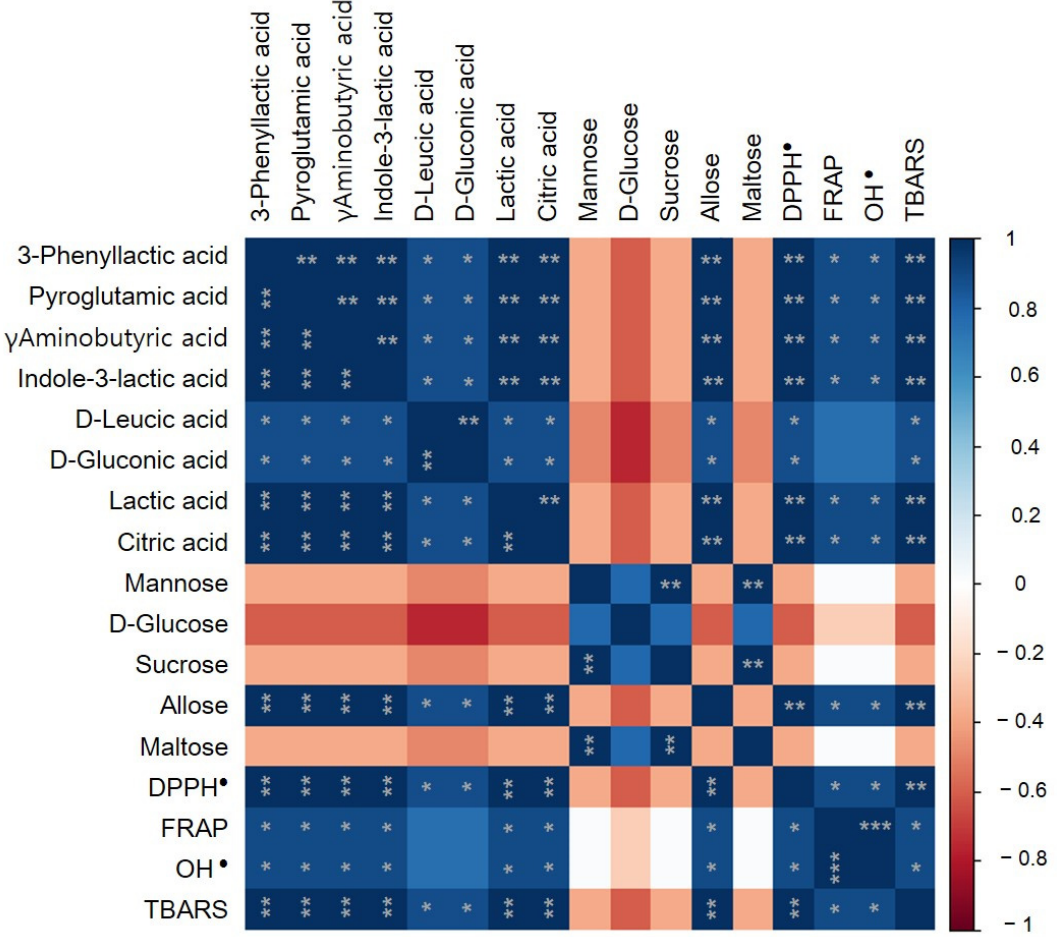
Figure 4. Spearman’s rank correlation. Relationships between antioxidant assays and metabolites. Spearman’s rank correlation coefficient ranged from 1.0 to − 1.0 and corresponded to a strongly positive or negative correlation, respectively (* p < 0.05; ** p < 0.01; *** p < 0.005).